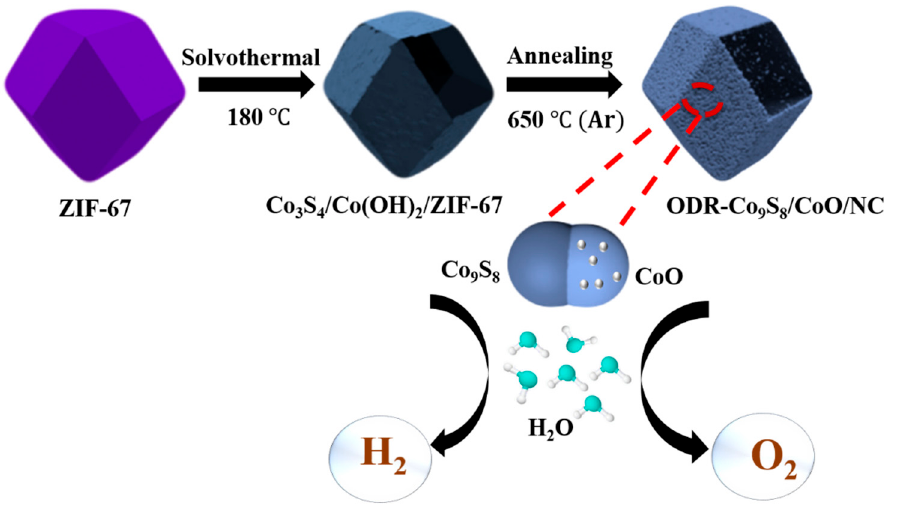
Figure 1. Schematic diagram of ODR-Co 9 S 8 /CoO/NC.